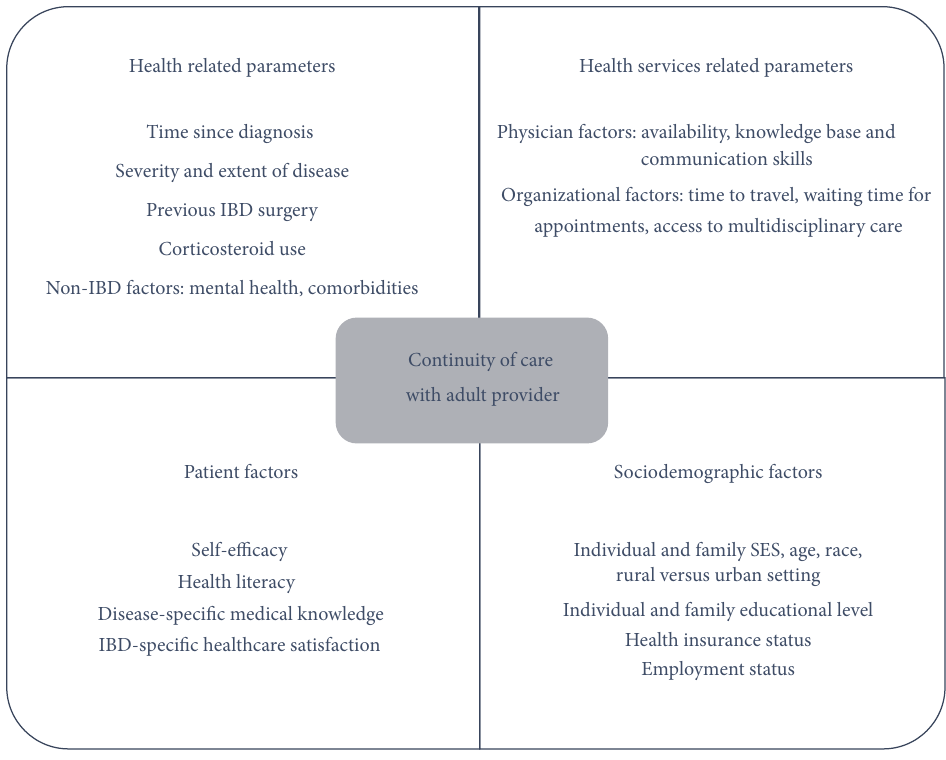
Figure 1: Conceptual model for the care of the emerging adult with IBD. SES: socioeconomic status.